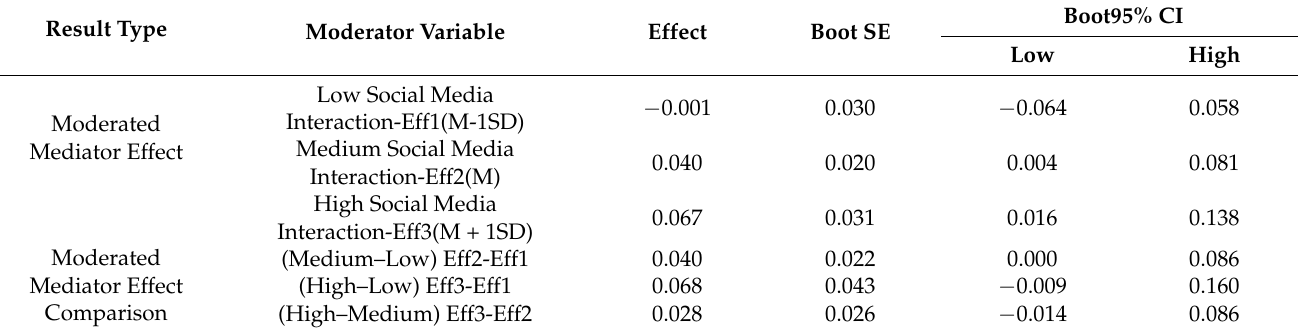
Table 10. Bootstrap test with moderated mediator effect.